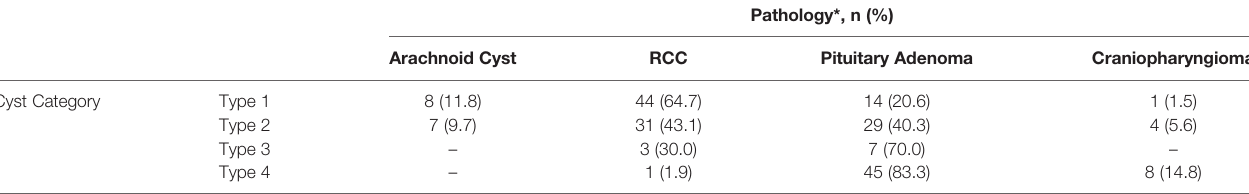
TABLE 2 | Cyst category by pathologic